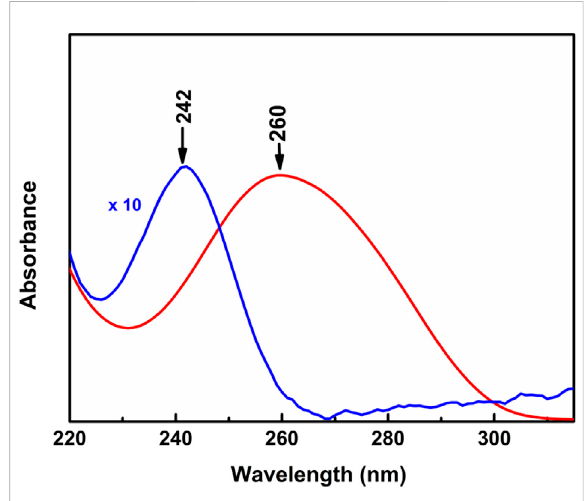
FIGURE 3 Absorption spectra of HC-Ct DNA in solution (red trace) and in the LB fi lm of HC-Ct DNA (blue